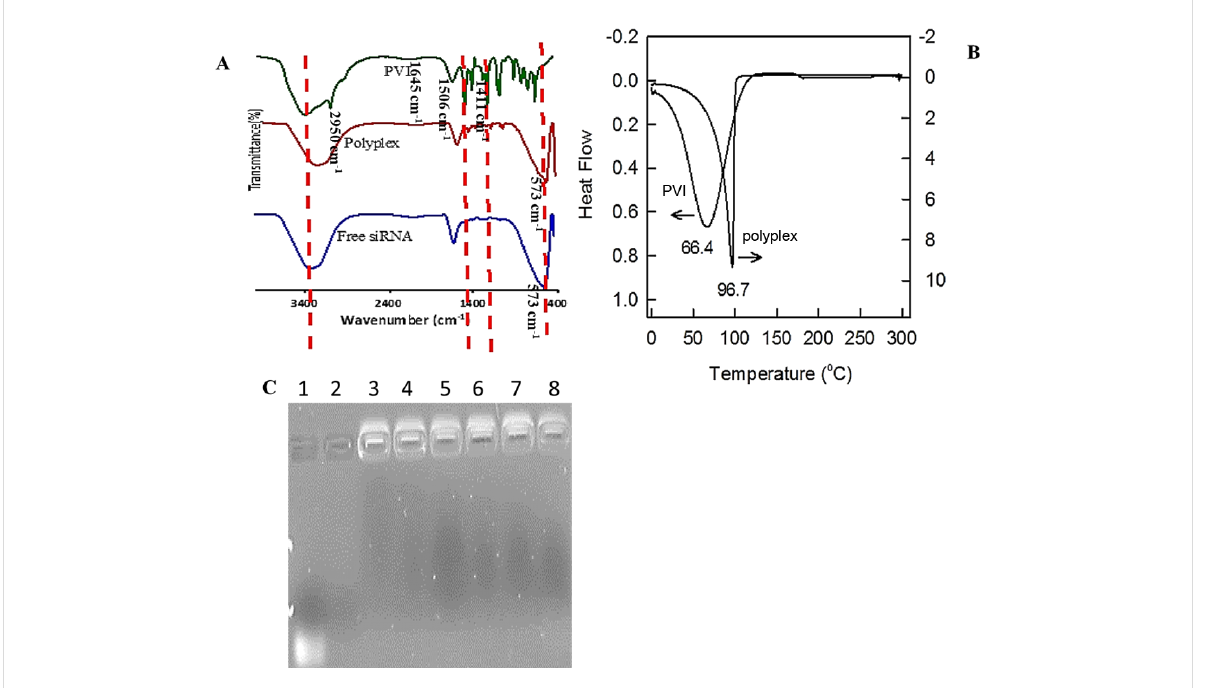
Figure 2: (A) FTIR spectra of free siRNA, PVI and the polyplex recorded in ATR mode between 4000 and 400 cm − 1 . (B) Heat flow profiles of pristine PVI and polyplex in nitrogen atmosphere at a scan rate of 5 °C·min − 1 . (C) Heparin displacement assay for the polyplex at different concentrations of heparin. Lane 1: free siRNA; lane 2: 60 ng/mL heparin only; lane 3: heparin/polyplex ratio (w/w) of 0.5; lane 4: heparin/polyplex ratio (w/w) of 1, lane 5: heparin/polyplex ratio (w/w) of 1.5; lane 6: heparin/polyplex ratio (w/w) of 2; lane 7: heparin/polyplex ratio (w/w) of 2.5; lane 8: heparin/poly- plex ratio (w/w) of 3. The absence of free siRNA in the polyplex lanes treated with heparin shows the stability of the complex formed.